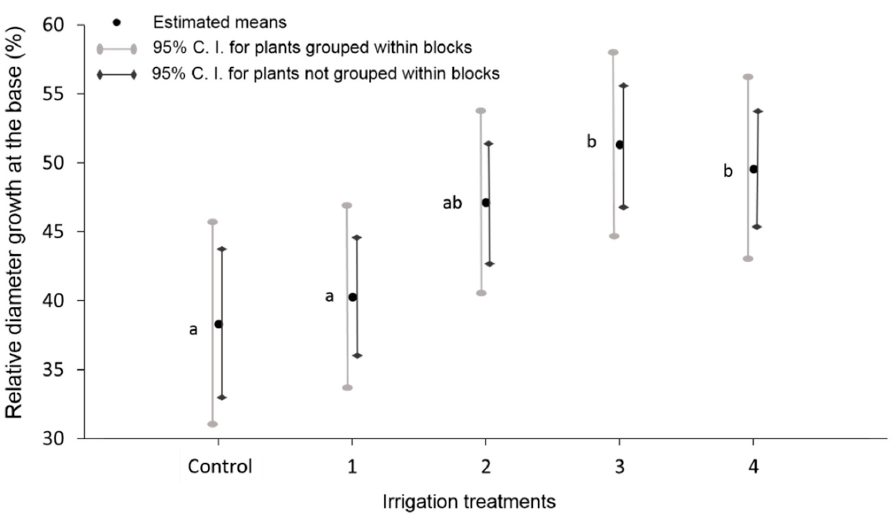
Figure 5. G.L.M.M. estimated marginal means of the relative diameter growth at the base (%) by irrigation treatments, with plants grouped or not within blocks. Different letters denote statistically significant differences at the 5% level without grouping plants within blocks as a random factor.